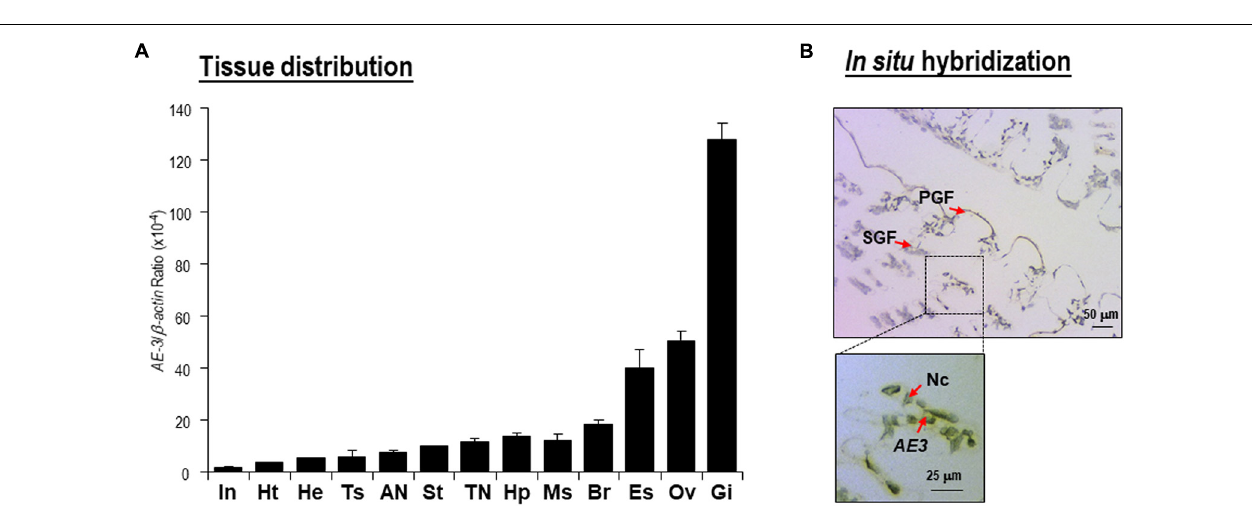
FIGURE 3 | Phylogenetic analysis (A) and structural comparison (B) of anion exchange proteins among various species.